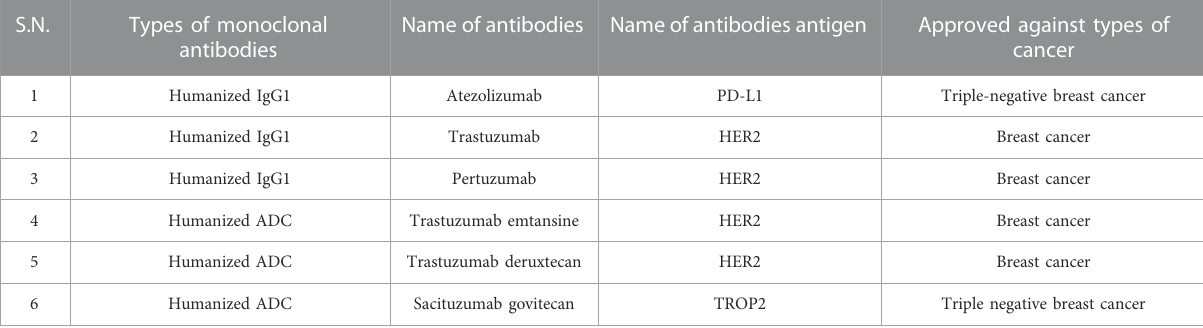
TABLE 4 List of monoclonal antibodies approved by the FDA. S.N.